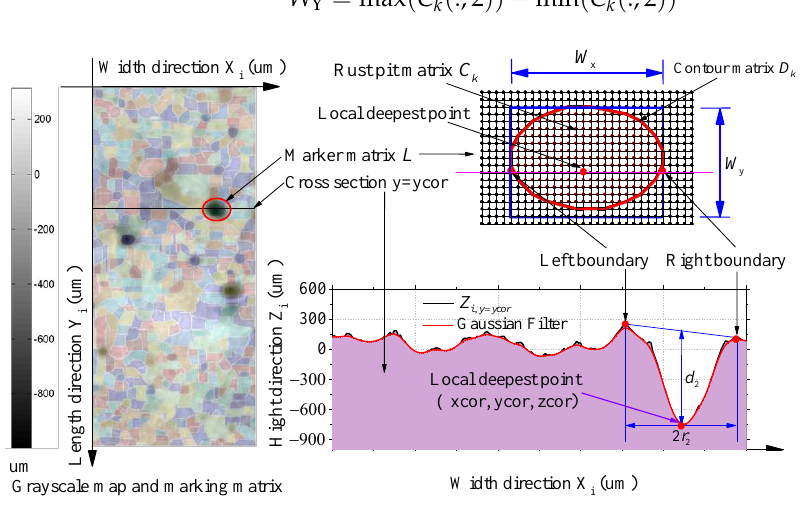
Figure 5. Calculation diagram of shape and size for rust pits.